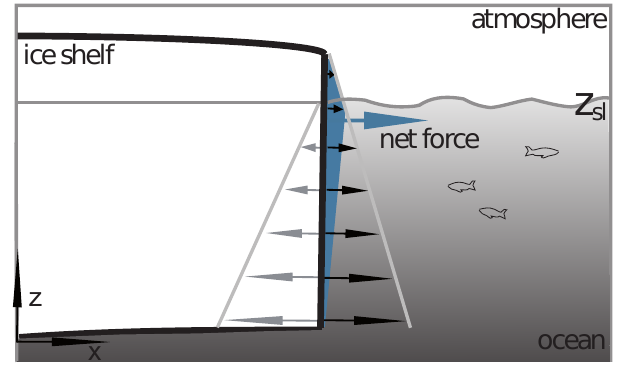
Fig. 2. Schematic diagram of forces at the calving front. Hydrostatic pressure (gray arrows) and cryostatic pressure (black arrows) result in net force in direction of the ocean (blue arrow). The net force is significantly reduced compared to a situation where the hydrostatic pressure is neglected.